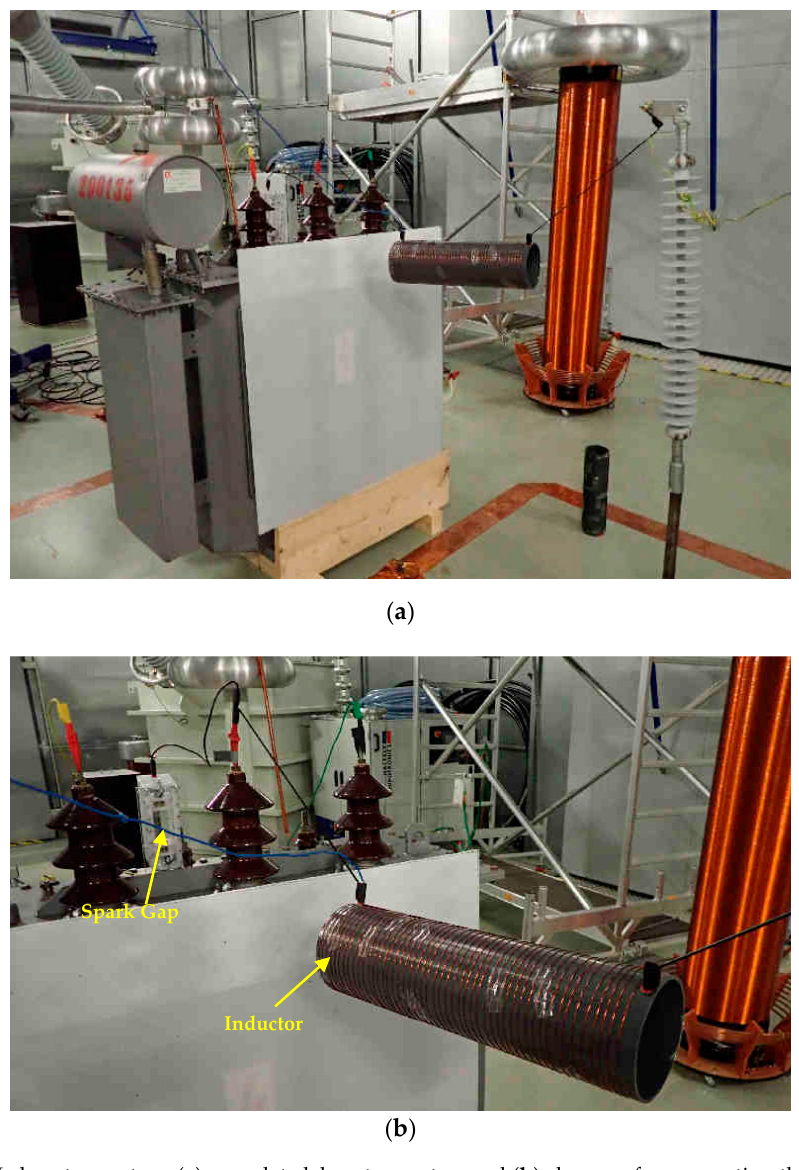
Figure 1. Laboratory setup: ( a ) complete laboratory setup and ( b ) close-up for connecting the inductor and spark gap to the transformer terminal.